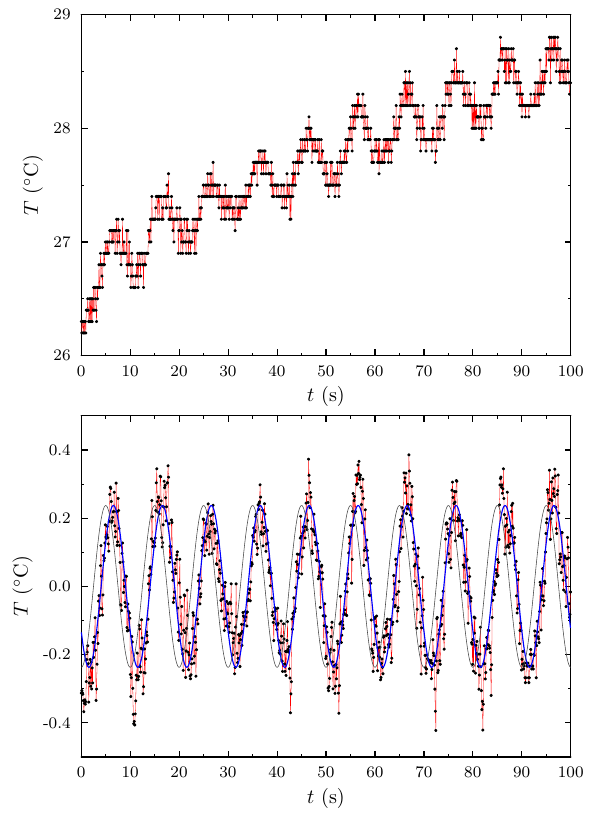
Fig. 5. (top) Measured temperature response for one point on the surface of the pipe. (bottom) The same data after the transforma- tion procedure to eliminate the non-oscillating mean component of the signal (black points). The blue line represents the result of nonlinear regression using sine function, see Eq. (9), which should correspond to the oscillating heat flux irradiating the heat transfer surface (see the gray line, which here o ff ers just an ap- proximate illustration of the temperature response phase